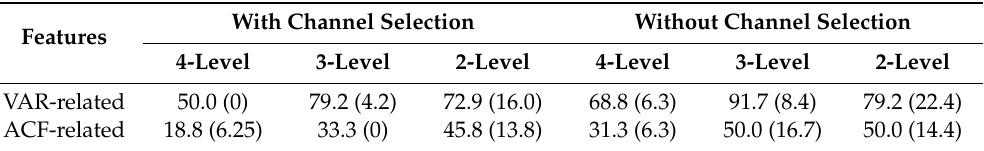
Table 8. Comparison of averaging classification accuracy (%) between VAR-related and ACF-related features (in the parentheses: